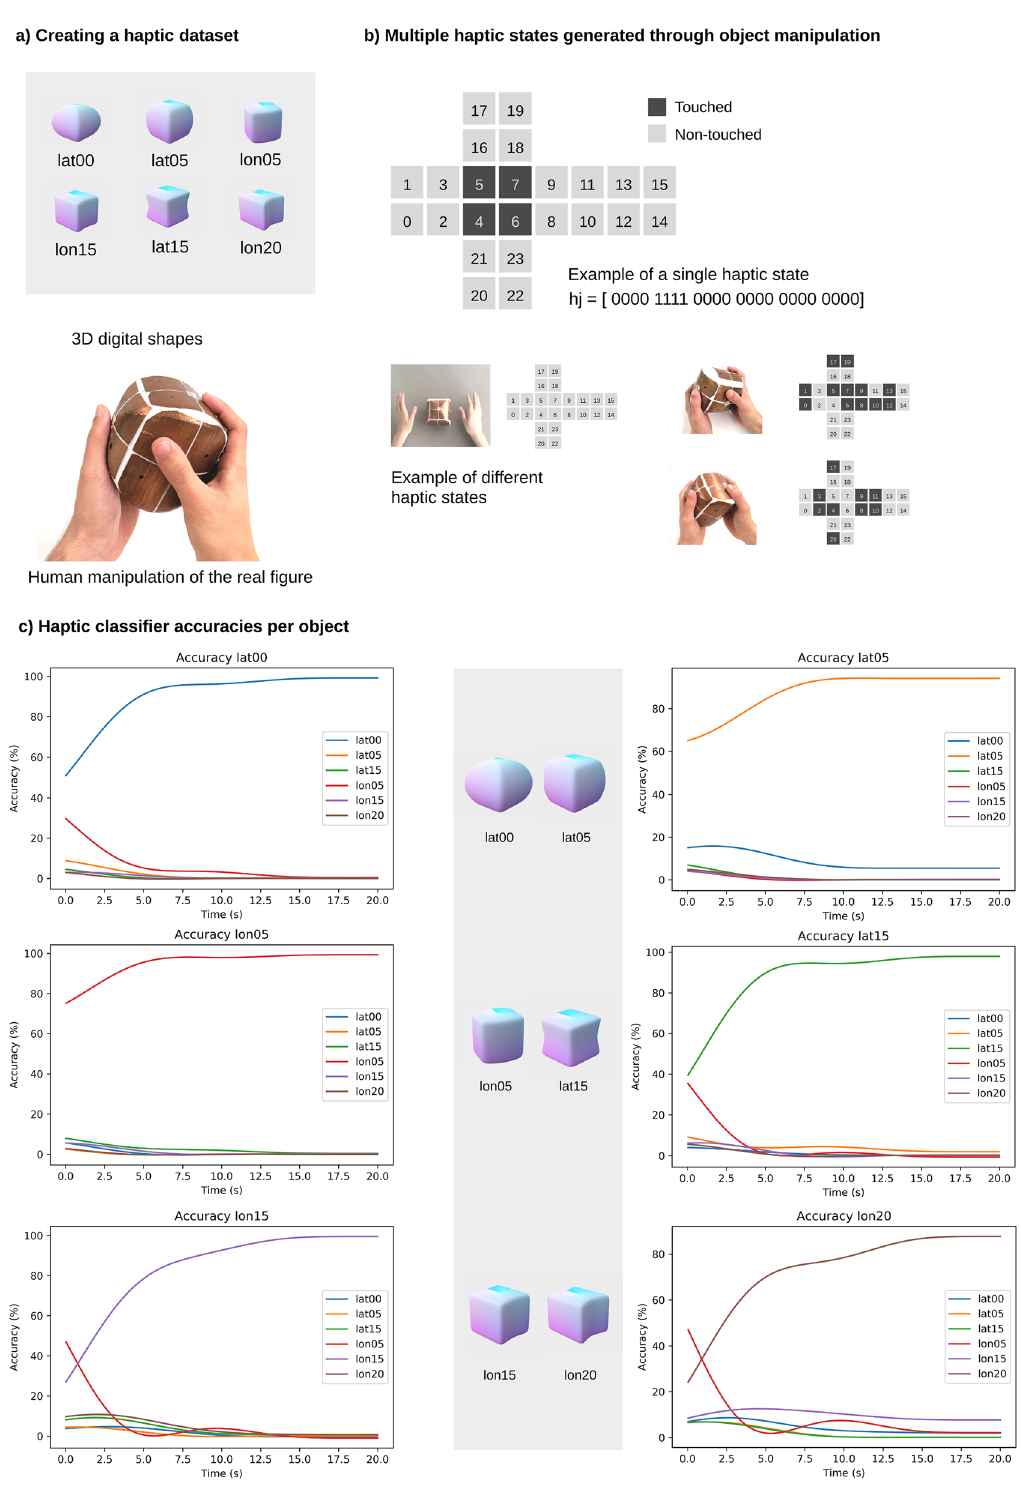
Figure 2. From object human manipulation to automatic haptic classification. ( a ) The objects of this study are six 3D printed shapes labelled as lat00, lat05, lat15, lon05, lon15, and lon20. The participant sits in front of a computer and follows instructions on how to manipulate the objects randomly. ( b ) The human manipulation data of the objects is collected by the system and are stored (forty times per second) as haptic states. A haptic state is represented by a 24-bit array and indicates the status of each sensor (touch/not touched). ( c ) ACS recognizes each object through a simple Bayes algorithm based on haptic states. As show in this subfigure, accuracies higher than 80% are consistently reached after a few